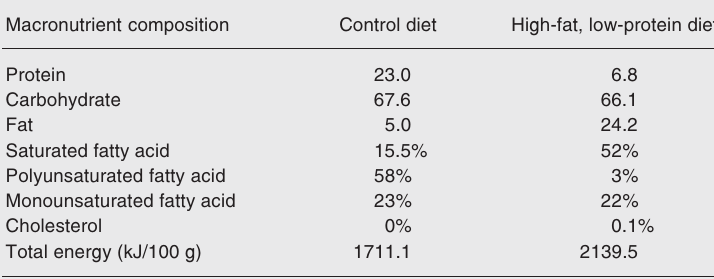
Data are reported as g/100 g diet and percent of total fat. Control diet is the standard diet for rats according to AIN-93G recommendations for rodent diets